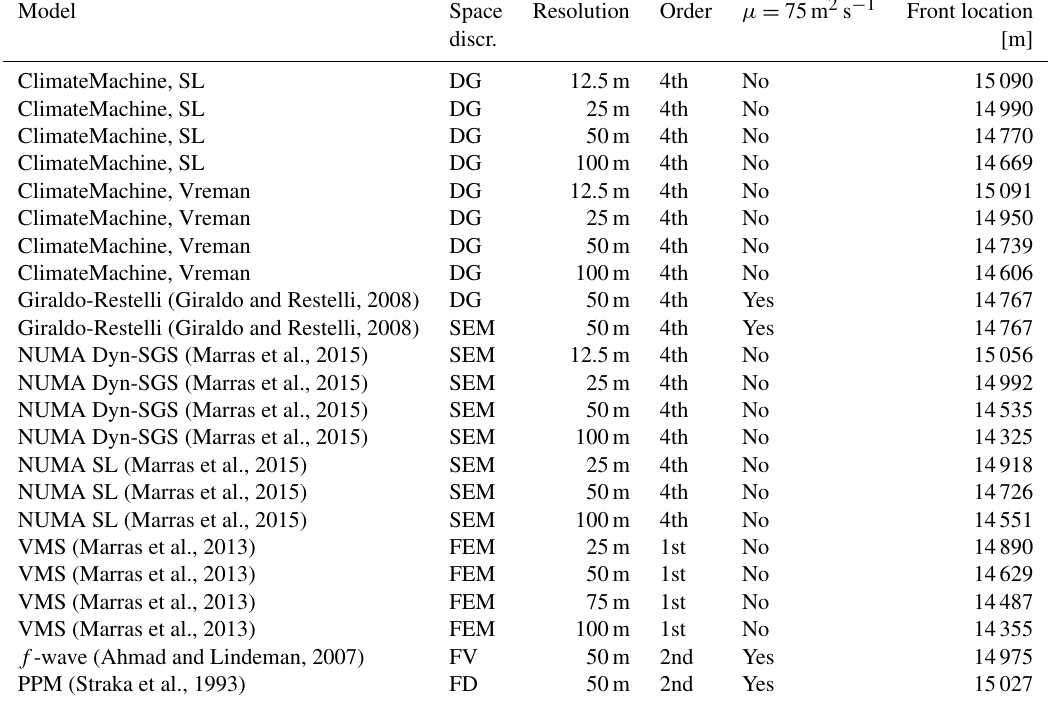
Table D1. Summary of frontal locations for the density current test case from existing literature. Results tabulated are of the front location at t = 900s. The results are reported for the following models: ClimateMachine with SL and Vreman, finite-element model (FEM) variational multiscale stabilization (VMS), f -wave, filtered spectral elements (SEs), filtered discontinuous Galerkin (DG), and the piecewise parabolic method (PPM). NUMA is the Nonhydrostatic Unified Model of the